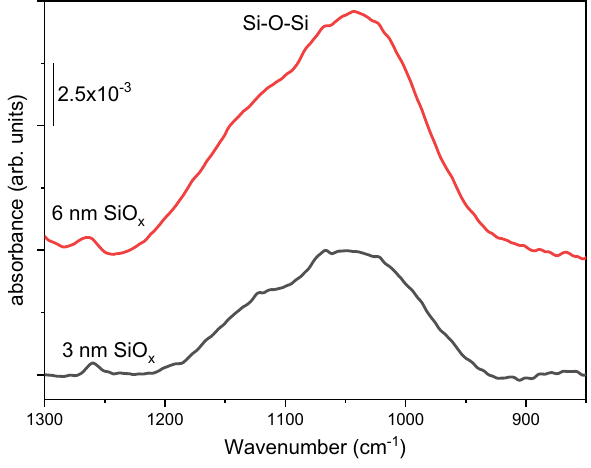
Fig. 3 DRIFTS data of plasma deposited ultra-thin SiO and 6 nm) on LSM Al 7075. The LSM Al 7075 sample was used as a